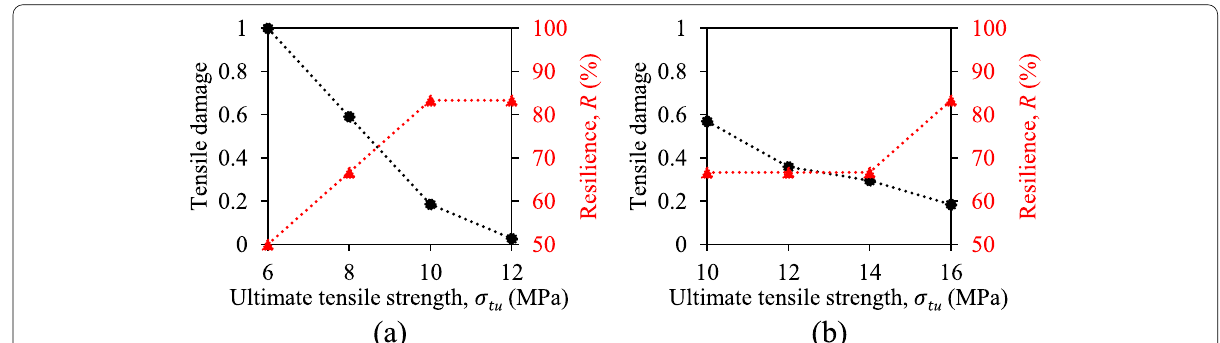
4 MPa and ε tu 4%); and b UHPC = =